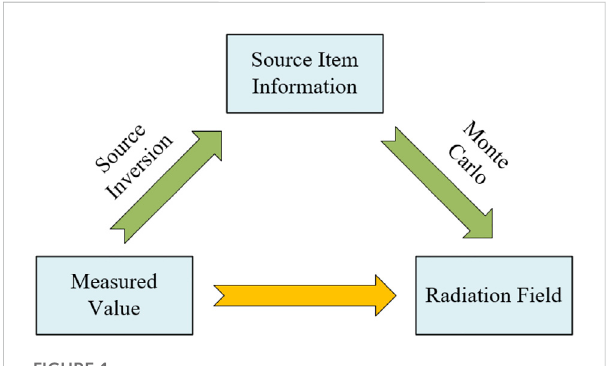
FIGURE 1 Flowchart of the radiation fi eld reconstruction algorithm.